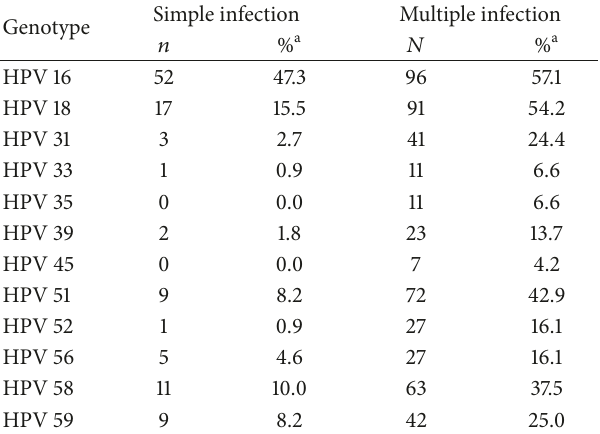
Table 1: Characteristics of participants. Table 2: Frequency of HPV genotypes in positive